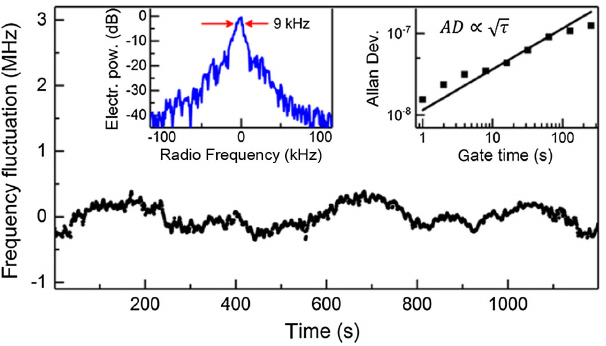
FIG. 4. Long-term frequency fluctuation of the first sideband with respect to the pump in the free-running mode, showing the repetition rate fluctuation of 160 kHz over 20 minutes. The left inset shows the linewidth of the beat note with a sweep time of 200 ms, measuring a narrow FWHM linewidth of 9 kHz; the right inset shows the frequency stability of the beat note, measuring an ffiffiffi p τ Allan deviation of 1 . 15 × 10 − 8 · when referenced to the THz